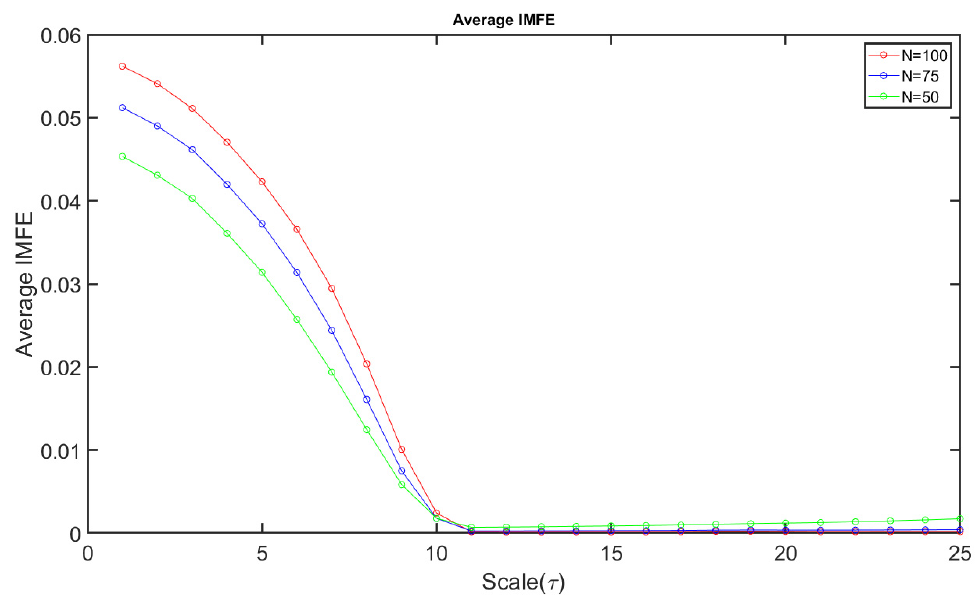
Figure 17. IMFE under different scales of IMF2.